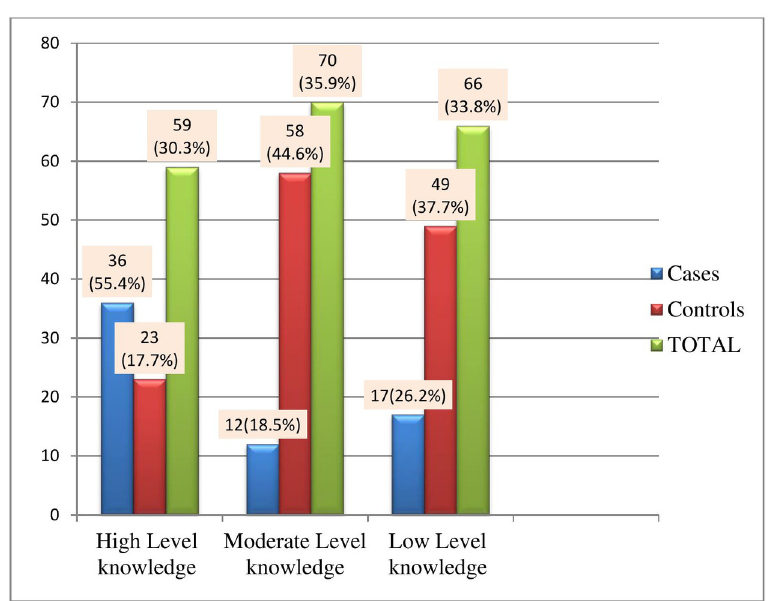
Fig 1. Knowledge of cervical cancer screening among women in the age group of 30–49 years in Ambo town, Oromia Regional State, Ethiopia, February to March, 2020.